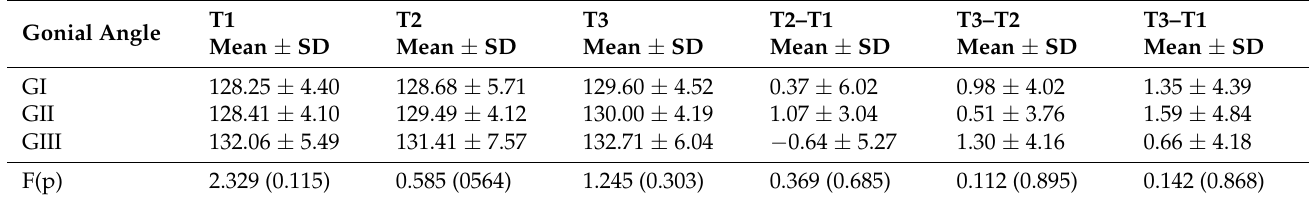
Table 3. Changes in gonial angle according to amount of mandibular setback.